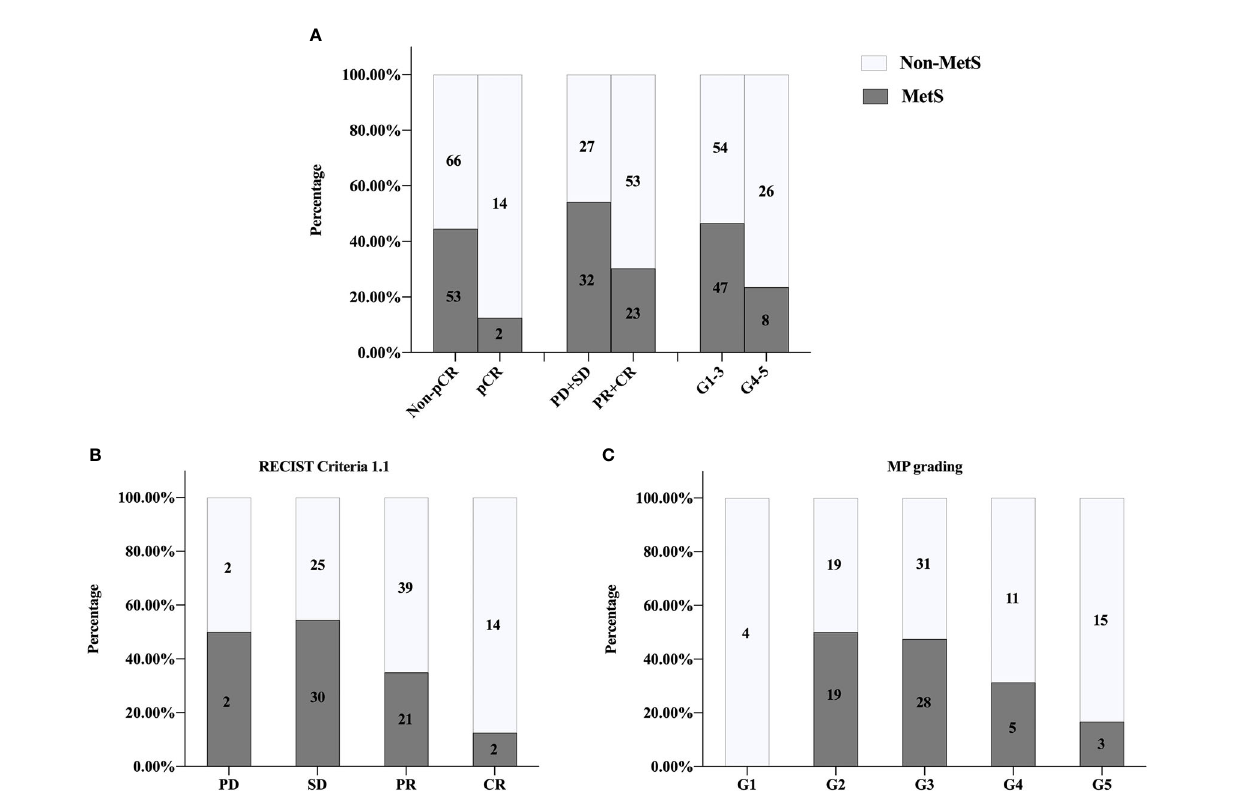
FIGURE 5 | External validation of univariate analysis on relationship between MetS and NACT response. (A) pCR, P = 0.011; clinical responses, P = 0.004; pathologic responses, P = 0.014. (B) RECIST1.1 criteria P < 0.001. (C) MP grading P = 0.048. MetS, metabolic syndrome; pCR, pathologic complete response; PD, progressive disease; SD, stable lesions; PR, partial response; CR, complete response; MP, Miller-Payne; RECIST, response evaluation criteria in solid